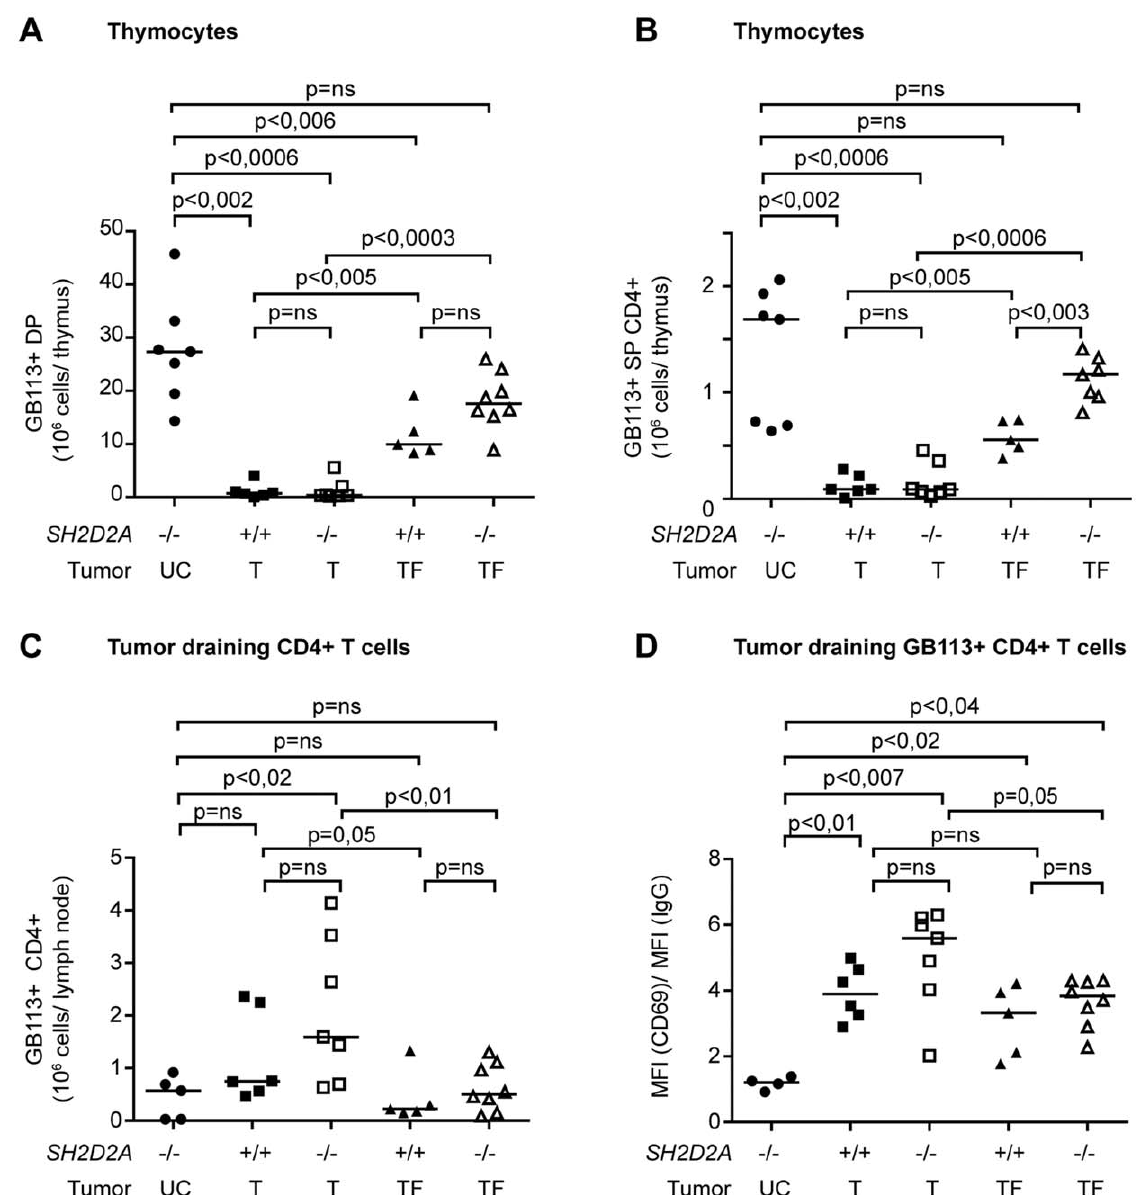
Figure 7. SH2D2A -deficient mice have increased numbers of Id-specific TCR–transgenic SP CD4 + thymocytes. The graphs represents from the left; ‘‘UC’’ –unchallenged mice, i.e. control Id-specific TCR-transgenic mice that did not receive tumor cells, wild-type ( SH2D2A + / + ) and SH2D2A deficient ( SH2D2A 2 / 2 ) mice that had to be sacrificed due to development of large tumors (tumor volume . 1 cm 3 ) (T=tumor) or that was tumor free at the end of the experiment 70 days after tumor inoculation (TF=tumor free). These tumor-free mice never had a palpable tumor during the course of the experiment, or they had a tumor that never reached 1 cm 3 and that disappeared prior to the end of the experiment. The median values are shown as lines in the diagrams. (A, B) Thymocytes from mice with indicated genotypes were labeled with anti Id-TCR (GB113), anti-CD4 and anti-CD8 mAbs and their expressions were monitored by flow cytometry. The total number of Id-specific TCR-transgenic (GB113 + ) double positive (DP, CD4 + CD8 + ) and single positive CD4 + (SP, CD4 + CD8 2 ) thymocytes is indicated for each genotype. (C) The diagram display the number of GB113 + CD4 + T cells in the tumor-draining lymph node of the same mice as in A and B. Of note is that the number of GB113 + CD4 + T cells in unchallenged mice is very low due to the small size of the draining lymph node in the absence of tumor challenge. (D) The GB113 + CD4 + T cells from the draining lymph node were labeled with anti-CD69 mAb, and their expression was monitored by flow cytometry. The diagram shows the median fluorescence intensity (MFI) of CD69 divided by the MFI of isotype control in GB113 + CD4 + T cells. P values were calculated with two-tailed Mann- Whitney U test. Ns=non-significant. doi:10.1371/journal.pone.0048239.g007 mice, independent of SH2D2A expression, is consistent with these indicates that SH2D2A deficient cells are less susceptible to the previous results. However, in the absence of SH2D2A , the numbers tolerizing effect of a large tumor inoculum. However, using the of GB113 + CD4 + SP thymocytes of tumor resistant mice were current experimental set up, we can not exclude that SH2D2A - significantly higher than in the wild type mice (Figure 7B). This deficient mice very rapidly eliminate the MOPC315 tumors